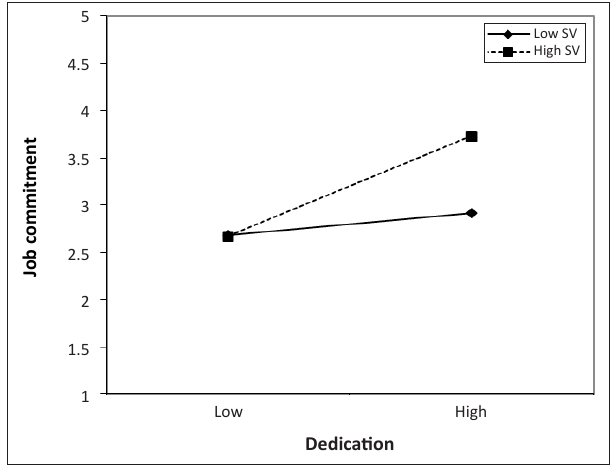
FIGURE 2: Service/dedication to a cause (SV) as a moderator of the relationship between dedication (work engagement) and job commitment.